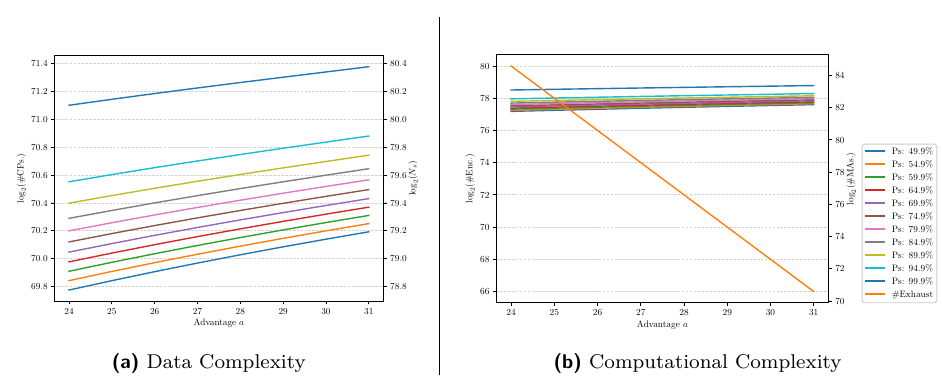
Figure 4: Relations between success probability, advantage, data complexity, and computational complexity of the attack using the model in [Sel08]. Note that in our attack, log log ( N ) − 41 + 32, and we assume #Encs . ’ 6 · 4 · #MAs . . 2